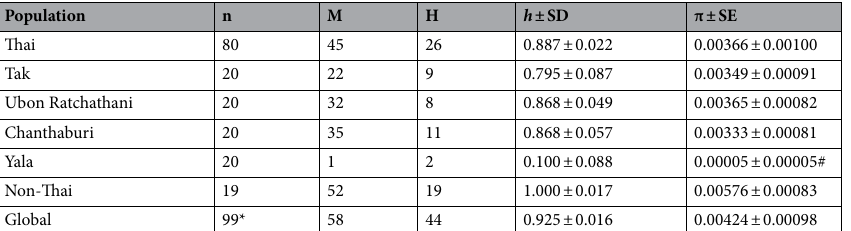
Table 1. Haplotype and nucleotide diversity of PfGARP among Thai and global isolates. *Complete gene sequences. M the number of mutation sites, H the number of haplotypes, h haplotype diversity, π nucleotide diversity, SD standard deviation, SE standard error. Test of the hypothesis that π for one province equals π for another province in Thailand: # p <